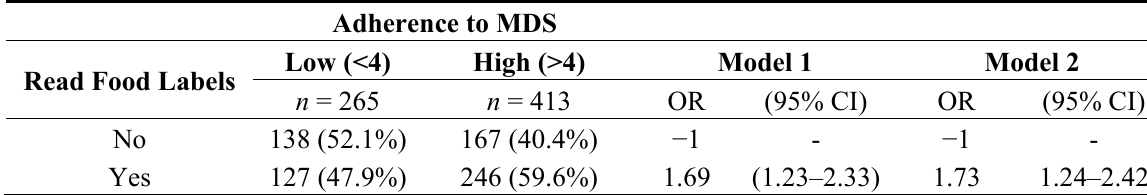
Table 5. Odds ratios of having high adherence to Mediterranean diet score (MDS) according to food labels reading.